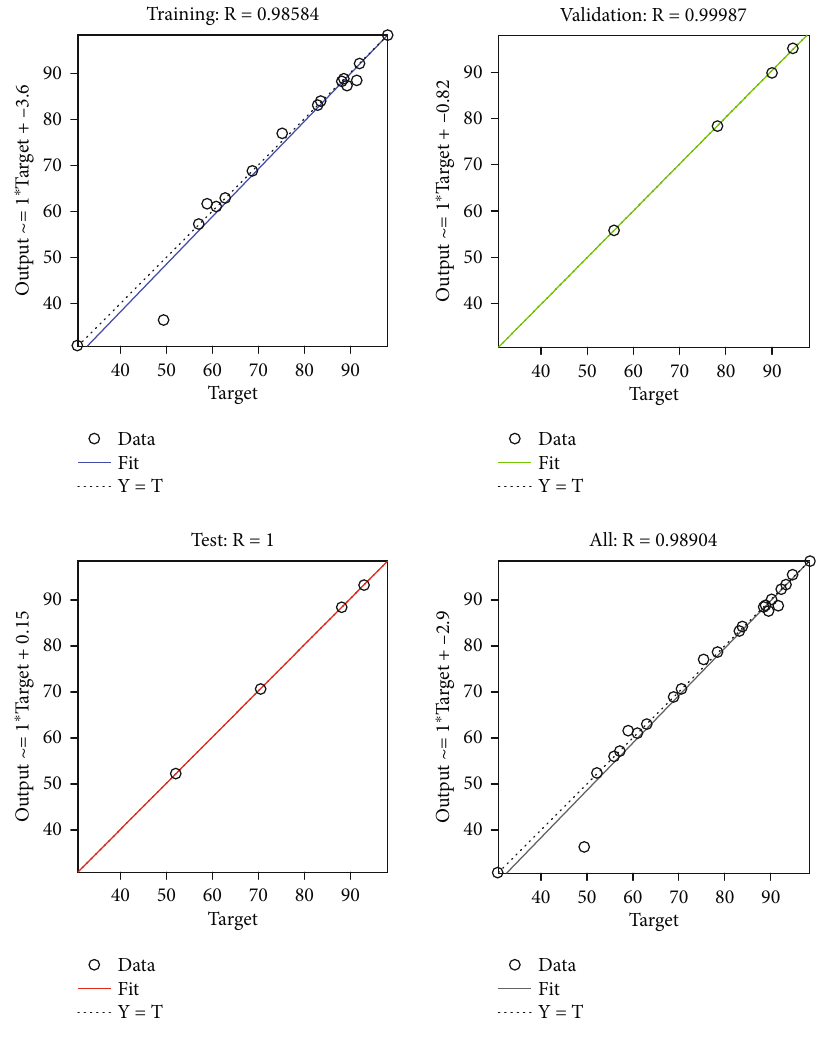
Figure 4: Training of ANN model. Table 4: Weights and biases for ANN